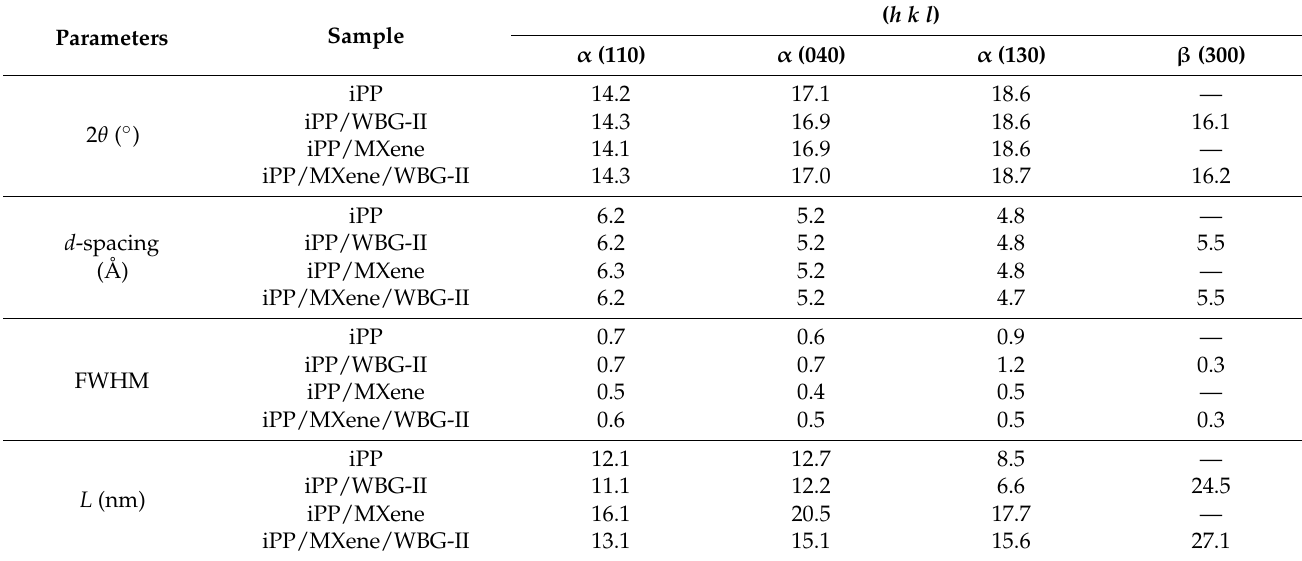
Table 2. WAXD parameters of four